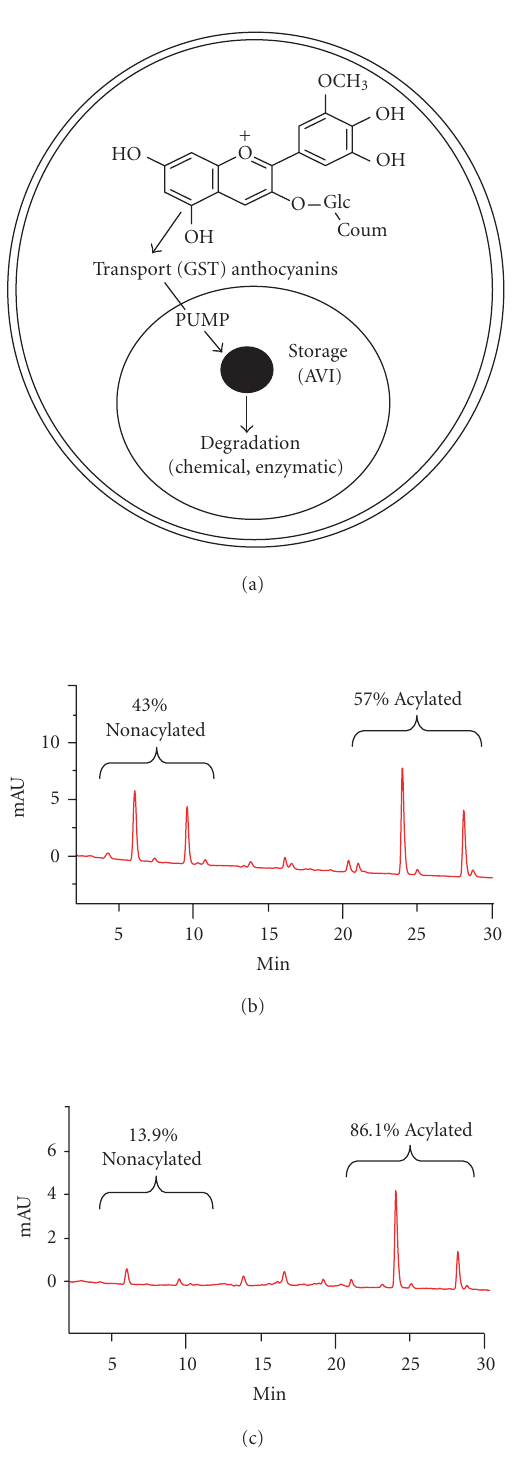
Figure 6. (a) A schematic of anthocyanin post-biosynthetic events. (b) HPLC profiles of whole cell. (c) HPLC profile of AVI extracts of the grape cell line at 520 nm. Nonacylated and acy- lated (p-coumaroylated) species are grouped and mean percent- ages of total peak area are shown ( n = 4). mAU = milli ab- sorbance